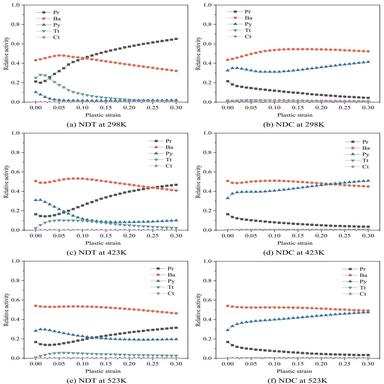
Deformation modes for the NDT and NDC at different temperatures show that the increase of Py activity suppresses the activation of twinning during tension, and the twinning activity is negligible during compression.